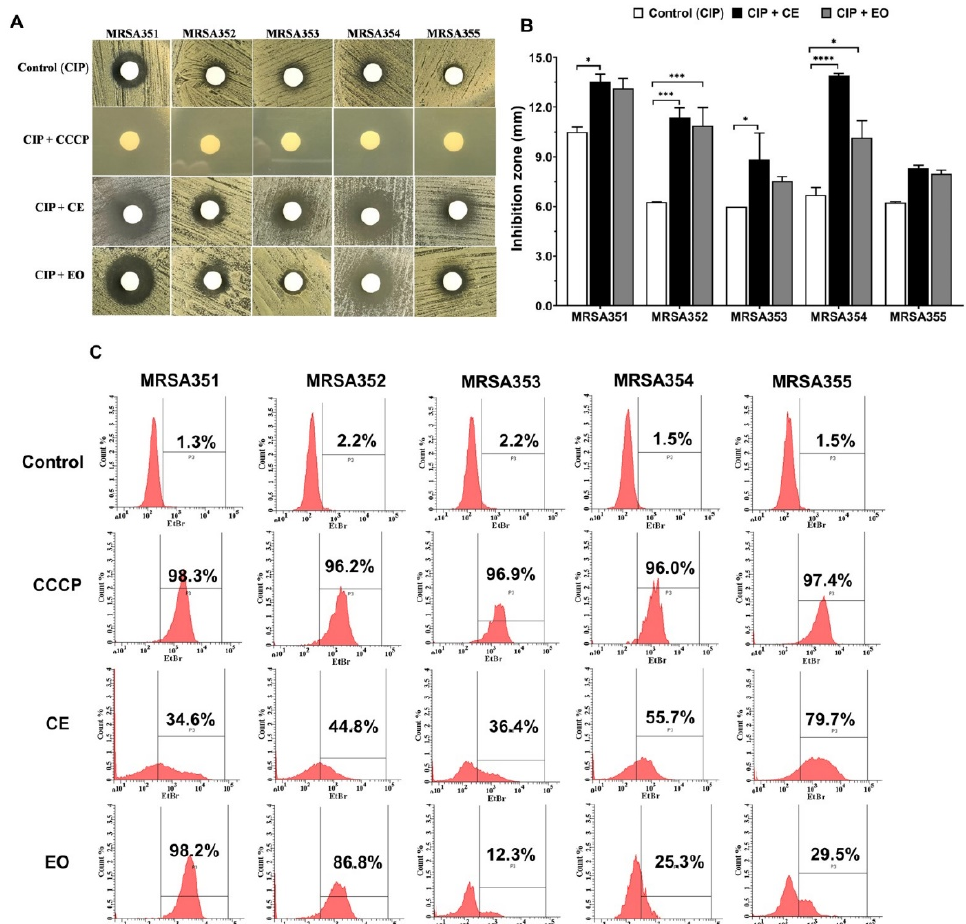
Figure 3. Potential effects of nutmeg crude extract (CE) and essential oil (EO) as efflux pump inhibitors in the five MRSA strains. Agar disc diffusion of the MRSA, combination of ciprofloxacin (CIP) with CE or EO, and its comparison with CIP and CIP with carbonyl cyanide m-chlorophenylhydrazone (CCCP) ( A ); inhibition zone (mm) of the MRSA, CIP with EC or EO, compared with CIP alone ( B ); flow cytometer analysis of intracellular accumulation inside the bacterial cells as indicated by the percentage of accumulation, including the control (EtBr), CCCP with EtBr, CE with EtBr, and EO with EtBr ( C ). *: p < 0.05; ***: p < 0.001; ****: p < 0.0001.